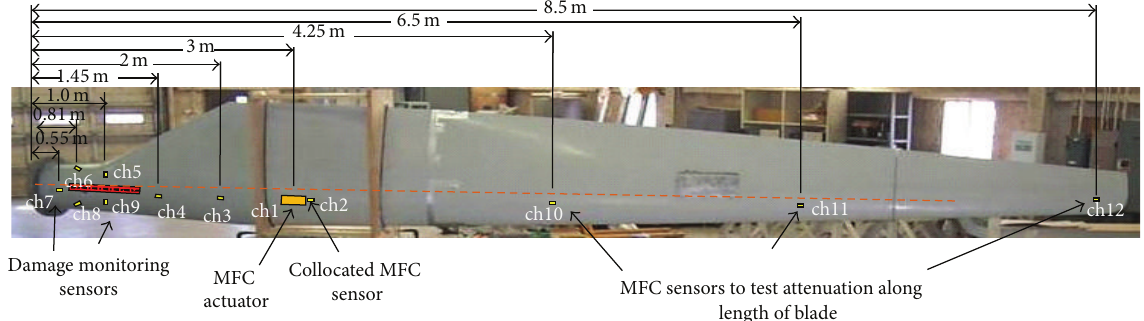
Figure 7: Overview of the fatigue test setup. A single MFC actuator in Ch1 is used to excite the blade, and 11MFC sensors are used to measure the